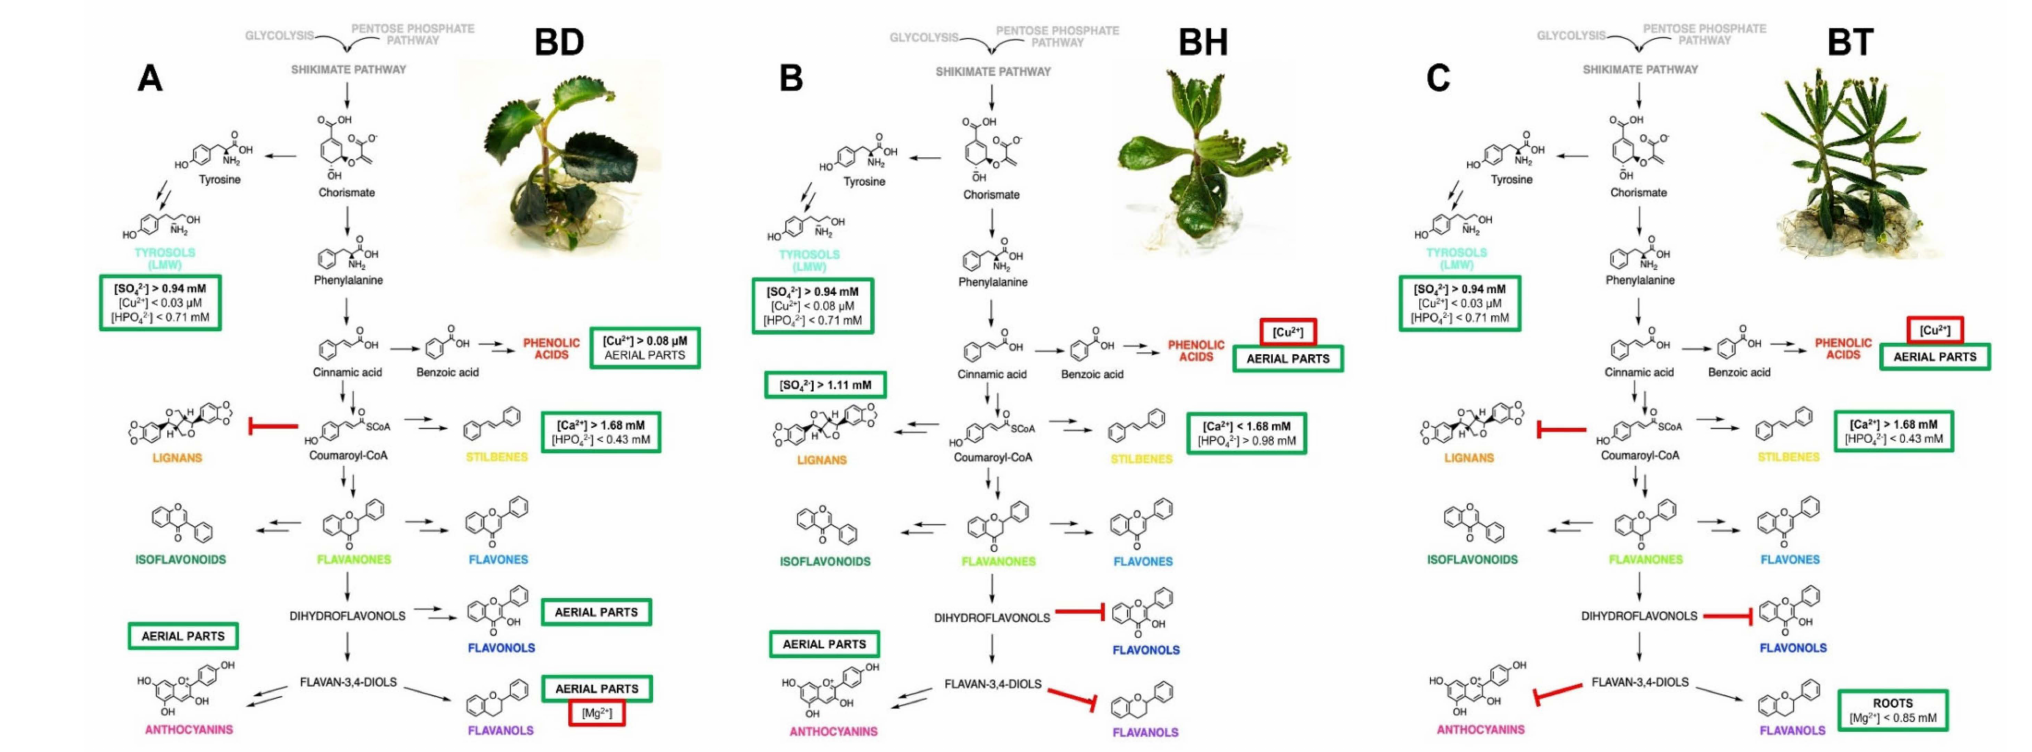
Figure 4. Proposed mechanism, as predicted by NFL modeling, for the biosynthesis of phenolic compounds in Bryophyllum cultured in vitro. ( A ) B. daigremontianum , BD; ( B ) B. × houghtonii , BH; ( C ) B. tubiflorum , BT. Green squares include the factors playing a positive role in the biosynthesis of each subfamily, whereas red squares include the factors with an inhibitory role. Bold letters indicate the most prevalent factor for each output, showing the highest contribution, according to the predictive